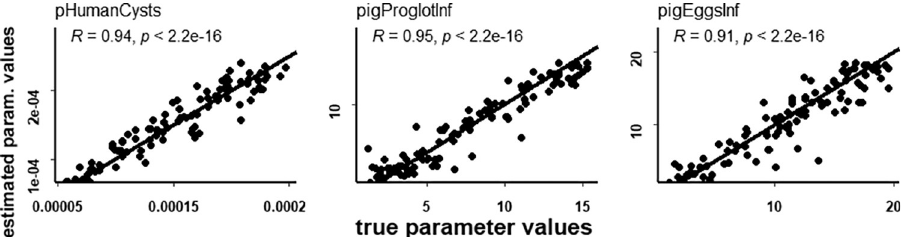
Fig 7. Cross-validation, simplified setup. Cross-validation for 100 randomly selected simulations from the simplified calibration setup, third stage. Estimated parameter values are compared to true values for the 3 calibration parameters with the identity line plotted as a reference. The correlation coefficient between estimated and true parameter values is shown for each parameter together with the corresponding p value.